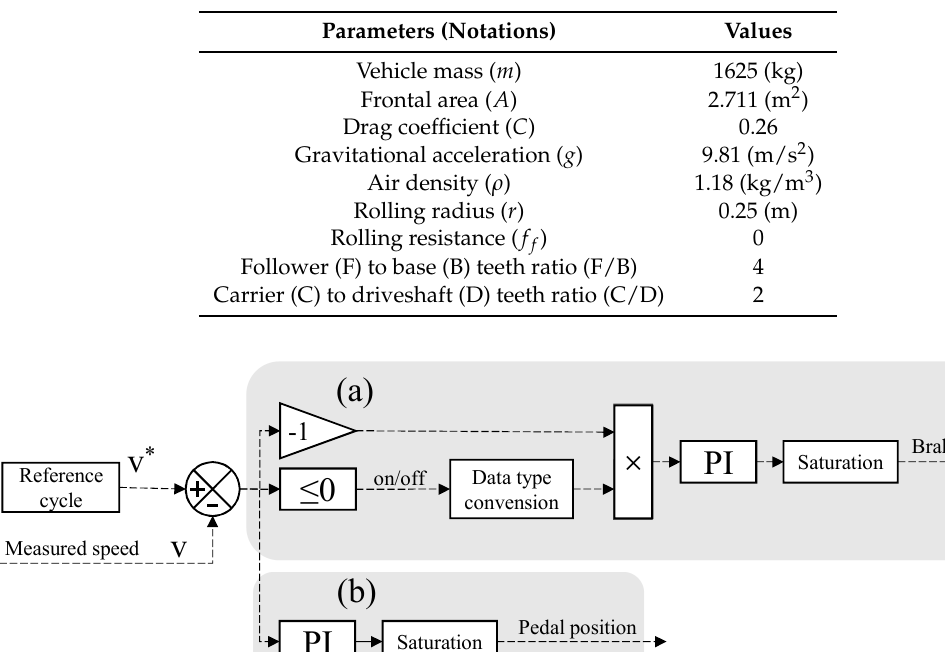
Table 5. Parameters of EV body.